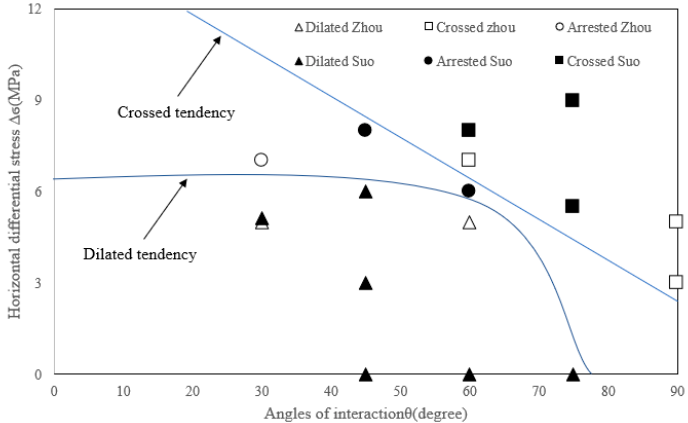
Figure 5. The model verification with experimental results.